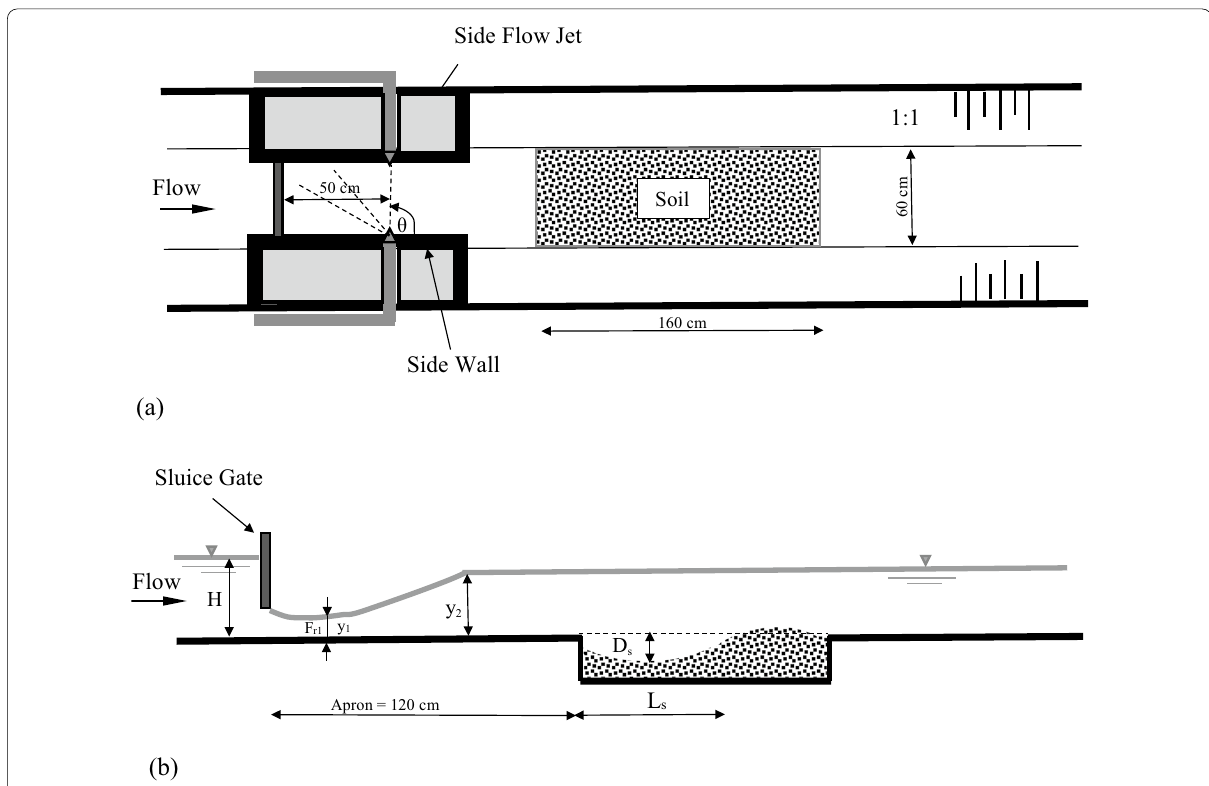
Fig. 1 Sketch of the experimental setup a plan and b side